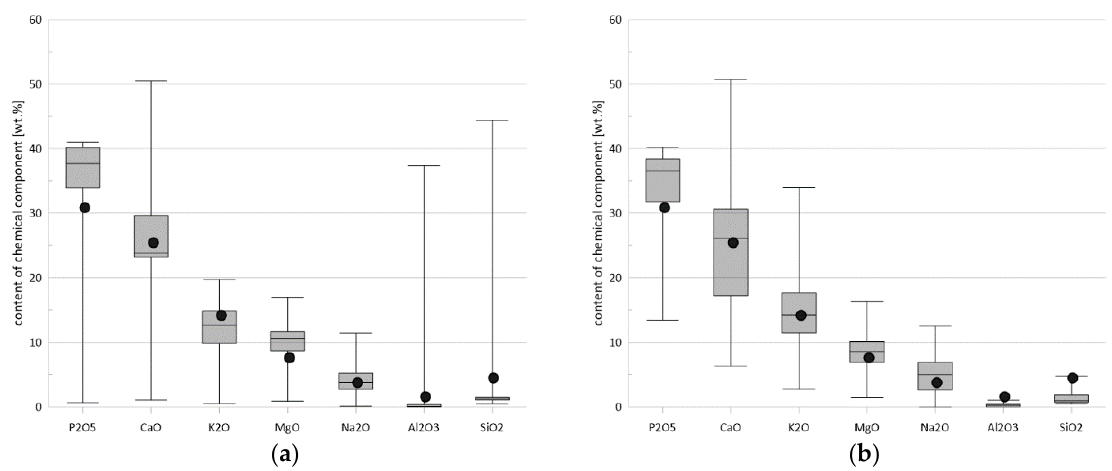
Figure 6. Chemical composition of selected ash grains in the samples of ash obtained in experiment E3 determined by the EDS method. ( a ) Chemical composition of selected ash grains in sample E3/C. ( b ) Chemical composition of selected ash grains in sample E3/KO. (centre line—median, box edges—percentiles 25%/75%, whiskers—minimum/maximum) and XRF method (spot) (note: element C was excluded from the analysis).